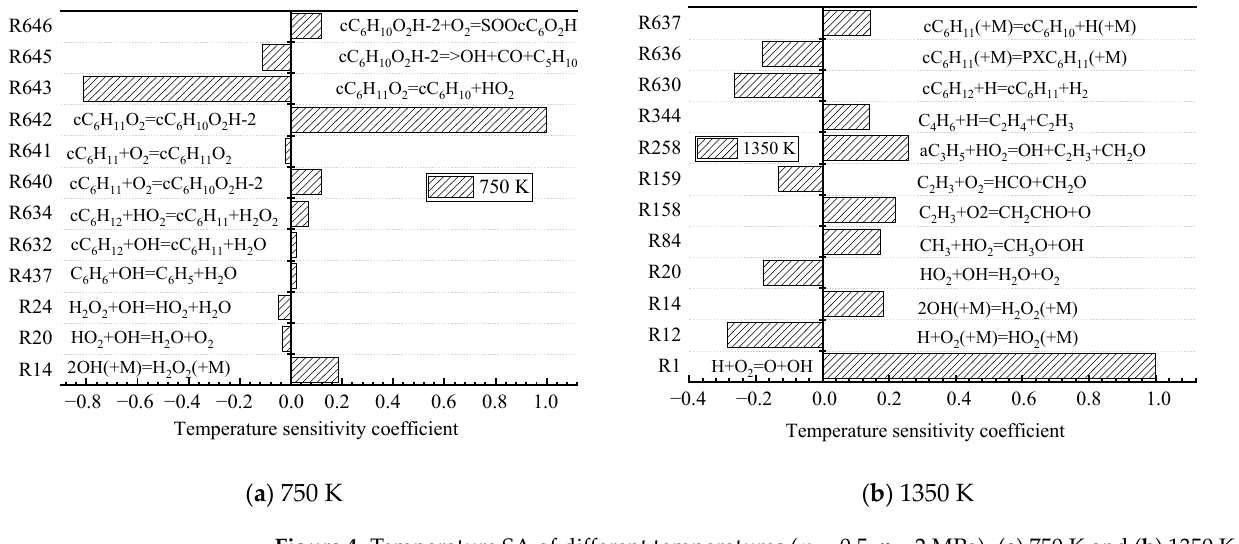
Figure 4. Temperature SA of different temperatures ( φ = 0.5, p = 2 MPa). ( a ) 750 K and ( b ) 1350 K. The temperature sensitivity of elementary reactions under different equivalence ratios is analyzed, and some elementary reactions with larger sensitivity coefficients are obtained, as shown in Figure 5. Under different equivalence ratios, large molecule reactions (R634, R640, R643, R645, and R646) and small molecule reactions (R14 and R19) became equally sensitive at temperatures of 1000 K. Notably, the elementary reactions R634 and R640 are less sensitive at 750 and 1350 K (Figure 4), but they have greater sensitivity at 1000 K. The HO 2 radical in R634 extracts the H atom in CHX, the generated H 2 O 2 is an important substance for the formation of OH radicals (R19), and R640 is an important path for the oxygenation reaction of CHX.